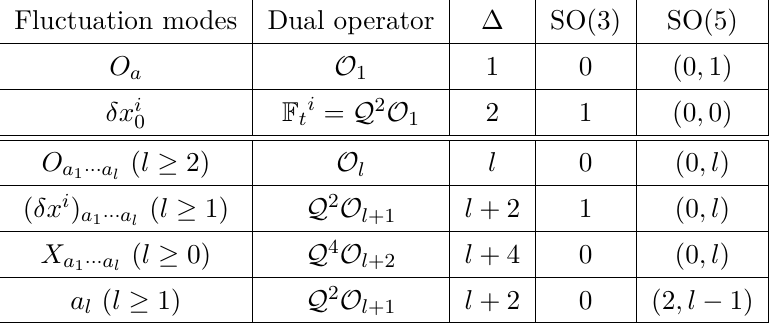
Table 1. In this table we summarize the quantum numbers of the operator dual to each fluctuation mode. ∆ gives the conformal dimension of the dual operator. The quantum numbers of the dual operator under SO(3) and SO(5) symmetry are given in terms of the Dynkin labels of the corresponding